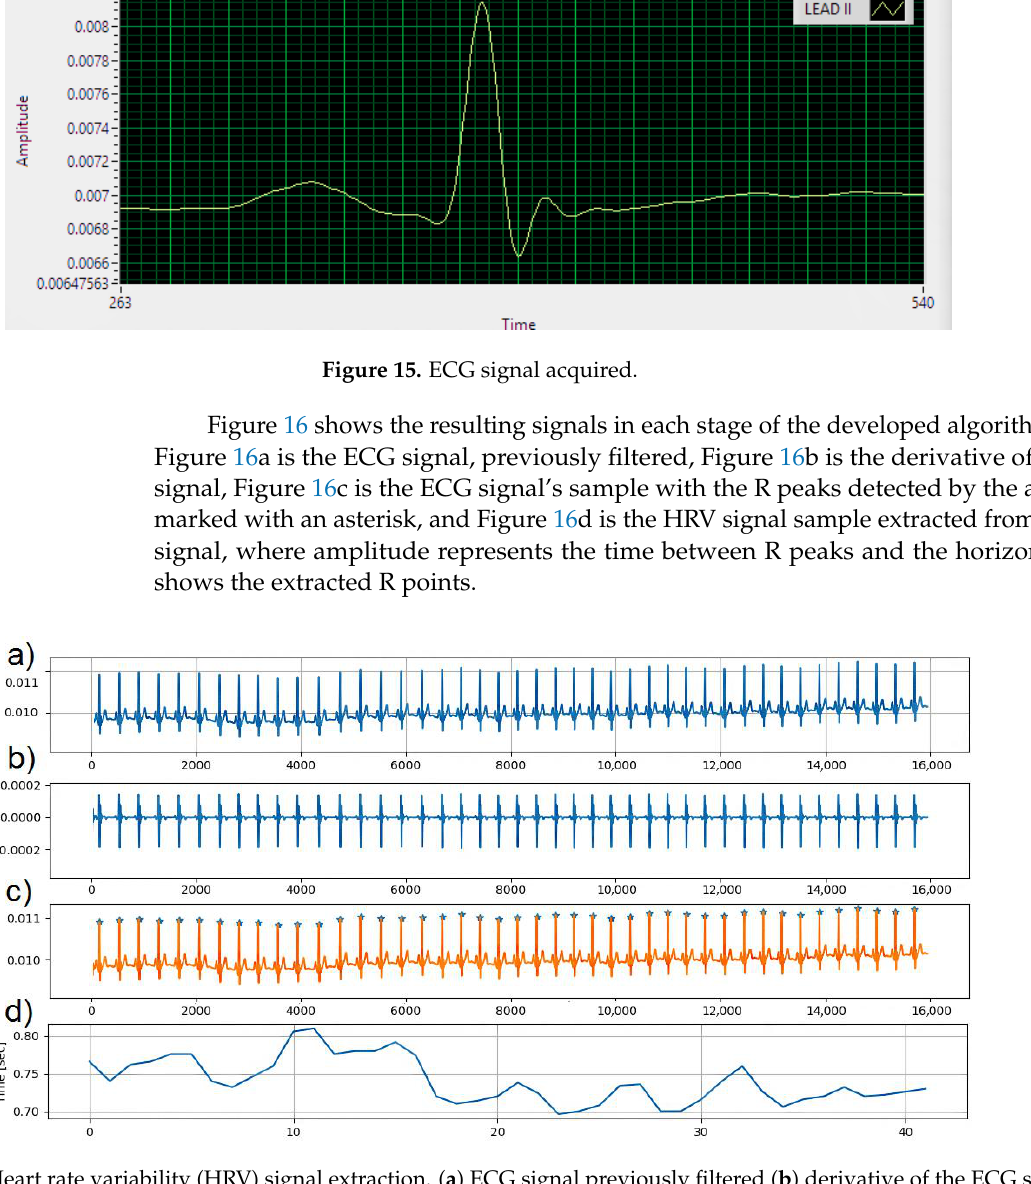
Figure 16. Heart rate variability (HRV) signal extraction. ( a ) ECG signal previously filtered ( b ) derivative of the ECG signal ( c ) ECG signal’s sample ( d ) HRV signal sample extracted.